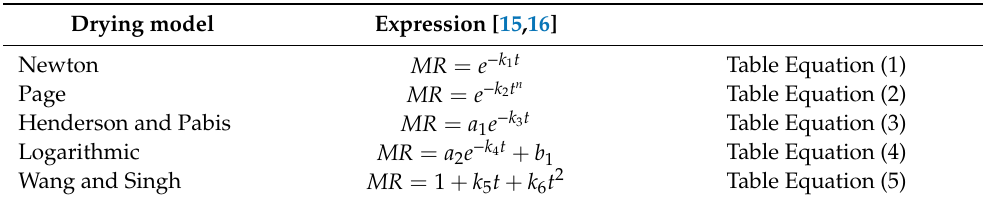
Table 1. Drying kinetics models considered in this work to describe moisture loss during freeze-drying of riboflavin-loaded gellan gum gels with di ff erent